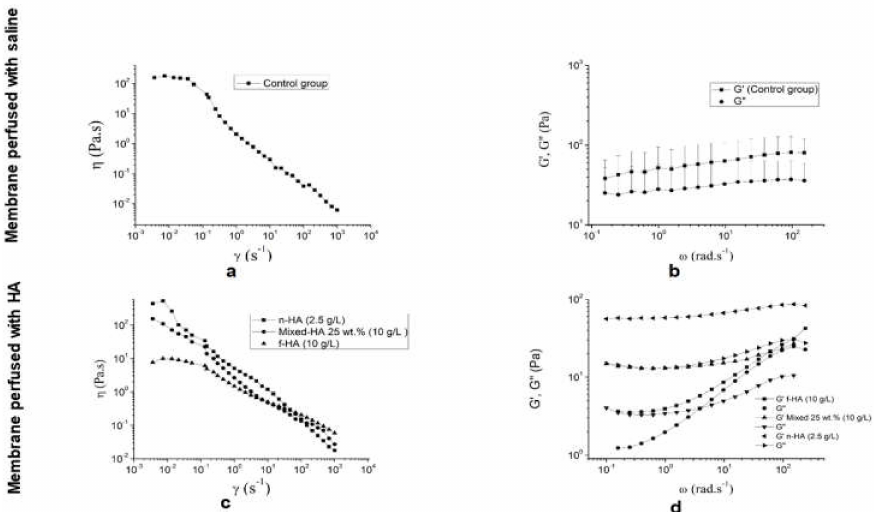
Figure 7. Profiles of shear viscosity ( a , c ) and viscous and viscoelastic modulus ( b , d ) of macerated small intestine of rats emptied after perfusion with saline solution (control) ( a , b ) and the HA formulations ( c , d ). Error bars represent SD =